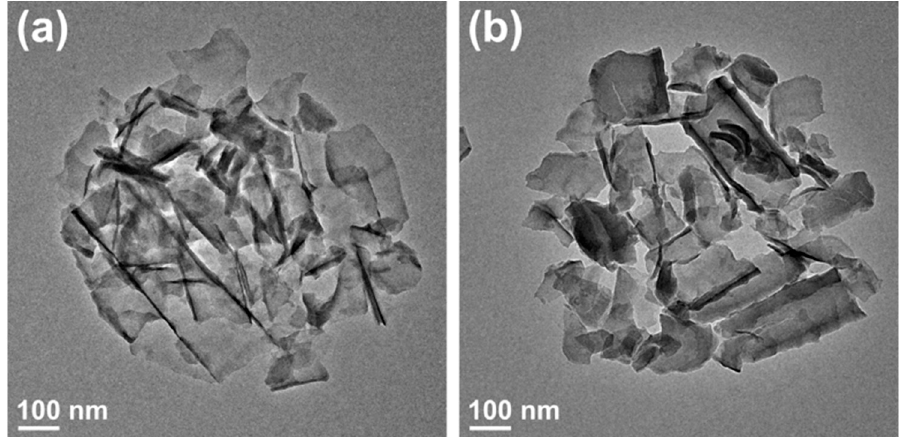
Figure 2. Low magnification transmission electron microscopy (TEM) images of micron-sized TANs: ( a , b ) Small aggregates of TANs recorded at RT and used for the in situ high resolution transmission electron microscopy (HRTEM) heating experiment.